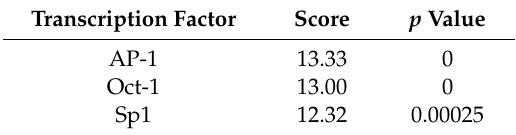
Data obtained with LASAGNA-search 2.0 [24].